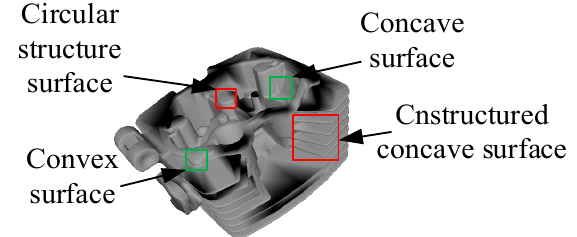
Figure 3. Unstructured cast solid surfaces.